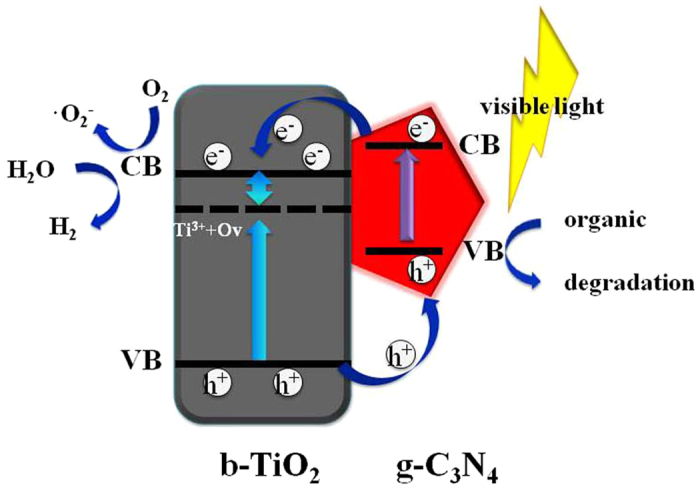
Proposed photocatalytic mechanism of b-TiO2/g-C3N4 composite under visible light irradiation.